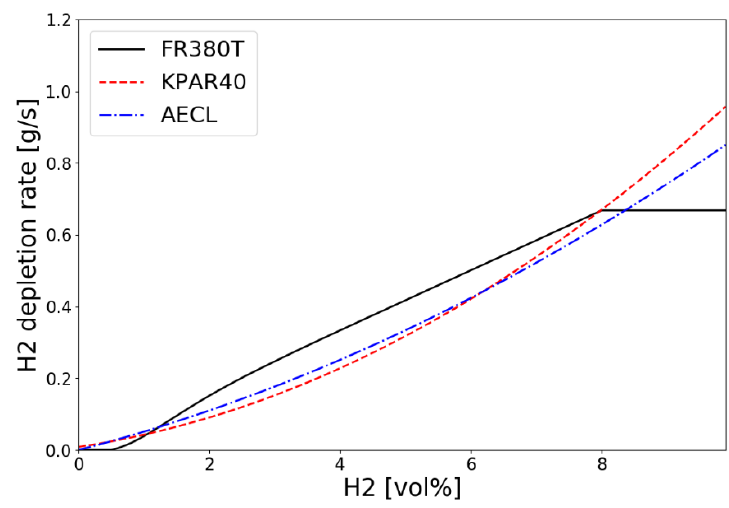
Figure 5. Hydrogen depletion rates along the inlet concentration for small PARs at T = 333 K and p = 1.5 bar.